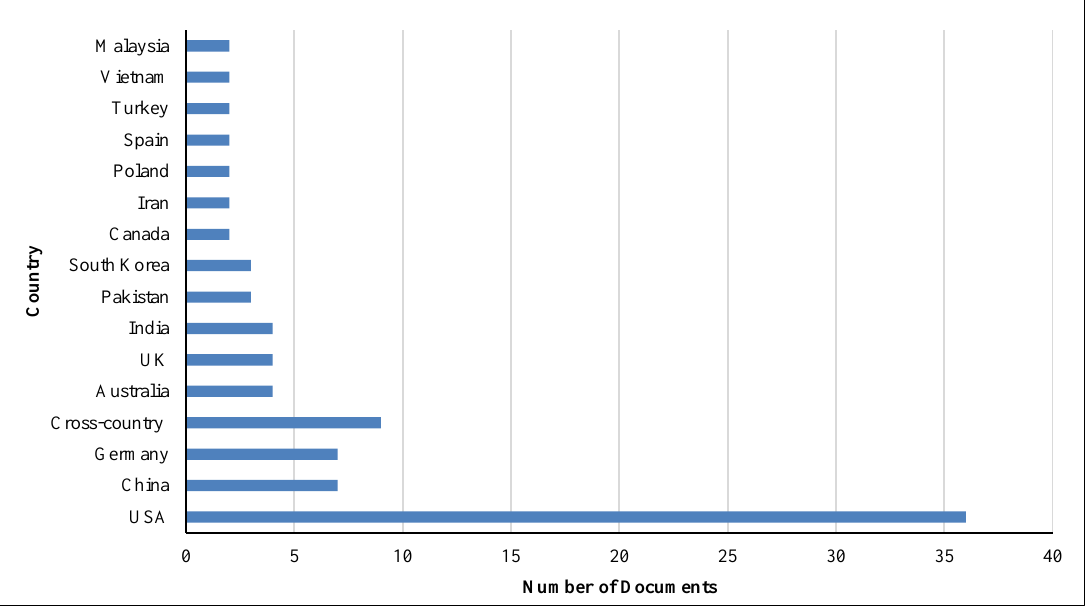
Figure 3. Geographical distribution of the sample literature (Note: Countries that were the subject of one study include Croatia, Israel, Japan, New Zealand, Portugal, South Africa, and